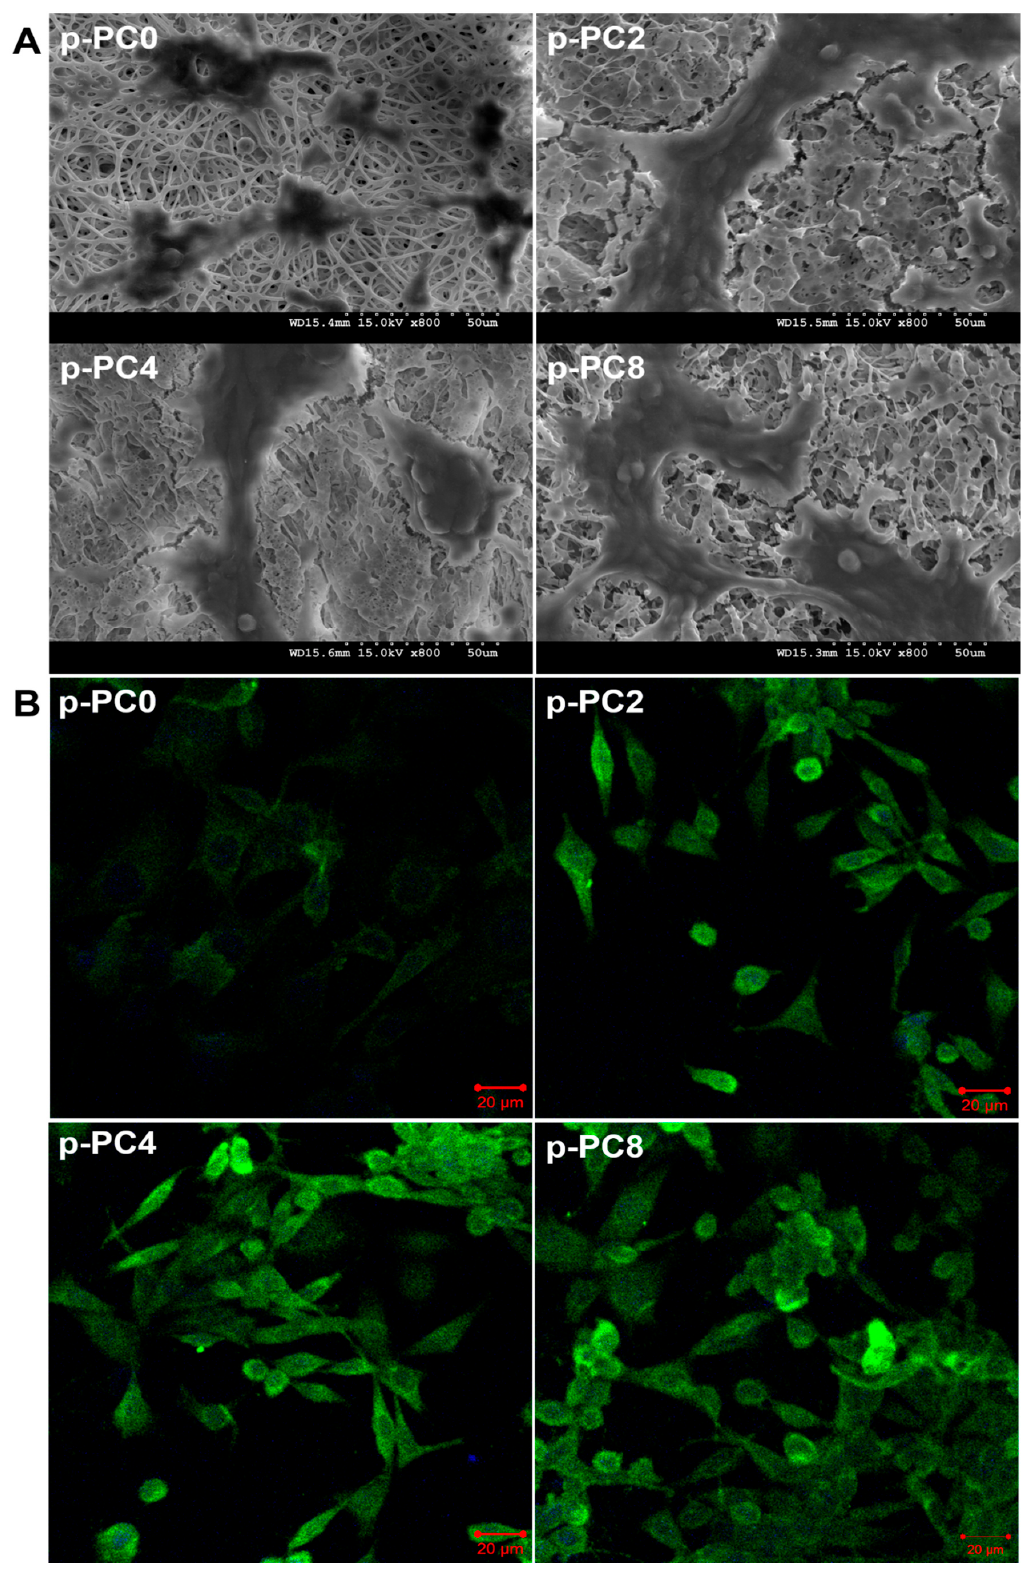
Figure 8. ( A ) SEM images of differentiated PC12 cells and ( B ) NF200 expression of PC12 cells in differentiation medium on p-PC0, p-PC2, p-PC4 and p-PC8 nanofibers.